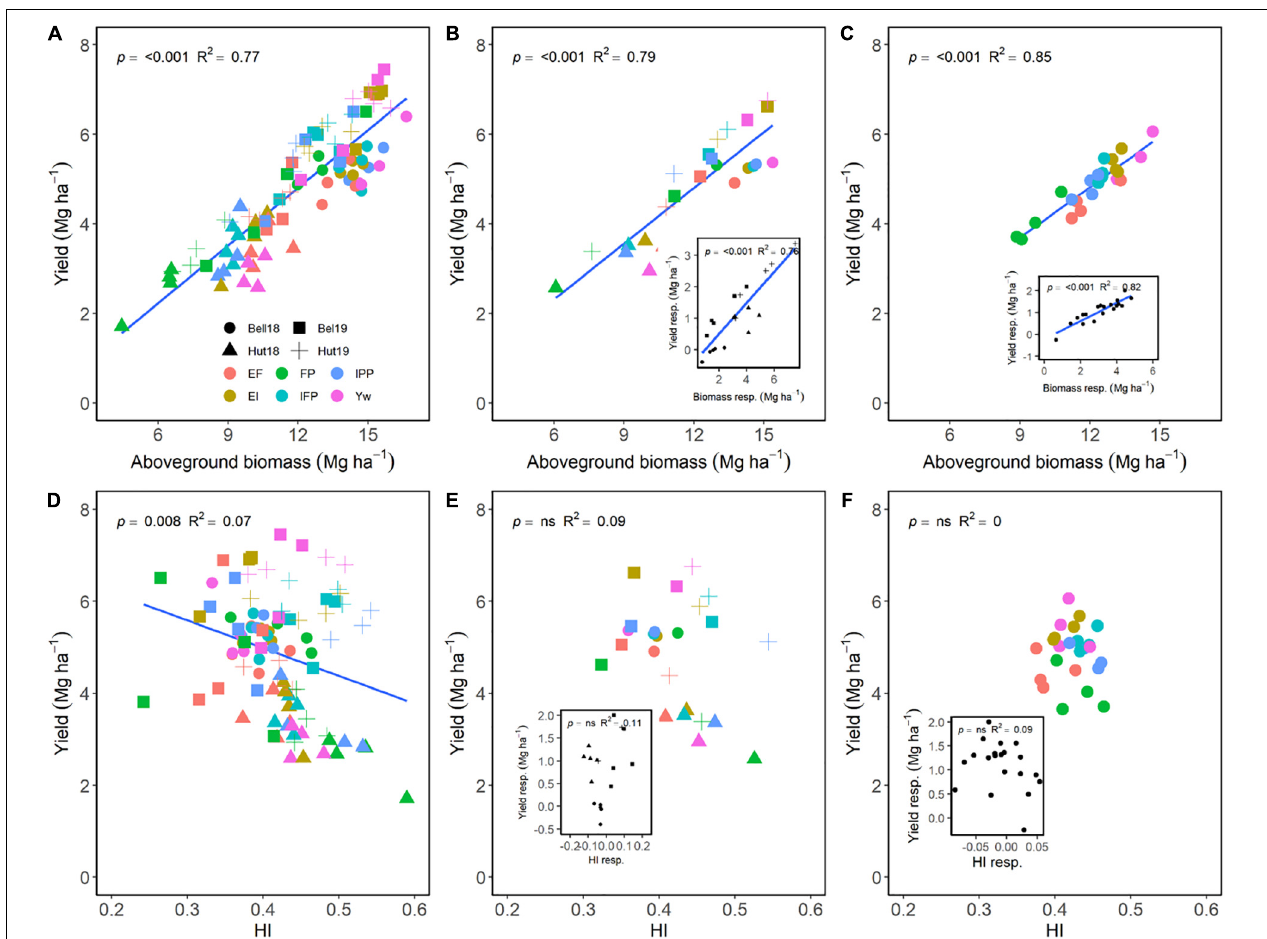
FIGURE 3 | Relationship between yield and aboveground biomass (A–C) or harvest index (D–F) at maturity across environments, wheat genotypes, and management systems ( n = 96) (A,D) , on average of each management for each environment ( n = 24; 6 management practices × 4 environments) (B,E) , on average of each genotype for each environment ( n = 24; 6 management practices × 4 genotypes) (C,F) . Inset graphs are the relationships between the responses of the variables to each management practices (difference between each management practice from the FP) averaged across either genotype for each management practice ( n = 20) or management for each environment ( n = 20) (C,F)